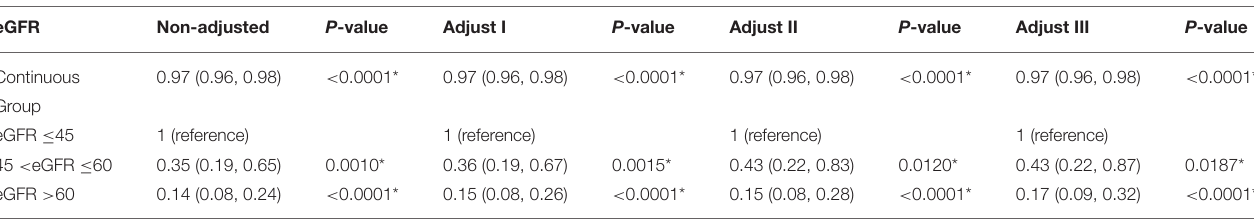
TABLE 3 | Multiple Cox regrssion analysis of eGFR in patients with